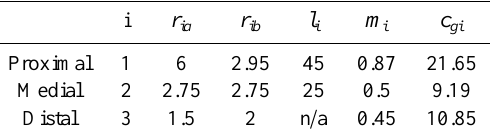
Table 1. Prototype physical parameters.